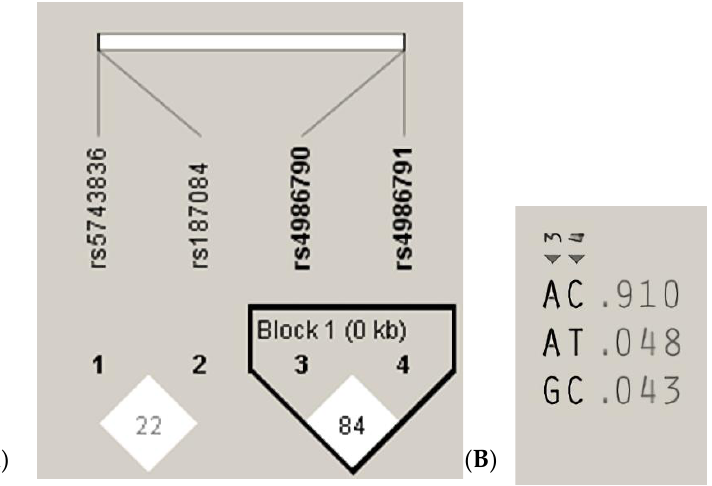
Figure 3. Linkage disequilibrium (LD) block structure of the TLR9 (1, 2) and TLR4 (3, 4) SNPs and haplotypes of the TLR4 gene from the 200 subjects. ( A ), LD plot; ( B ), haplotype analysis.